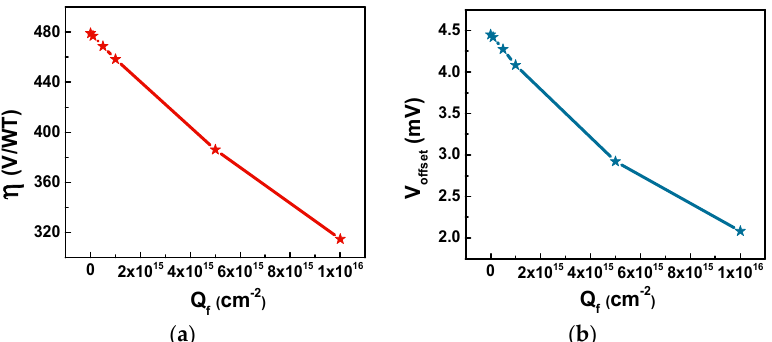
Figure 4. Simulated ( a ) efficiency factor ( η ), and ( b ) offset voltage ( V offset ) as a function of fixed charge densities ( Q f ).